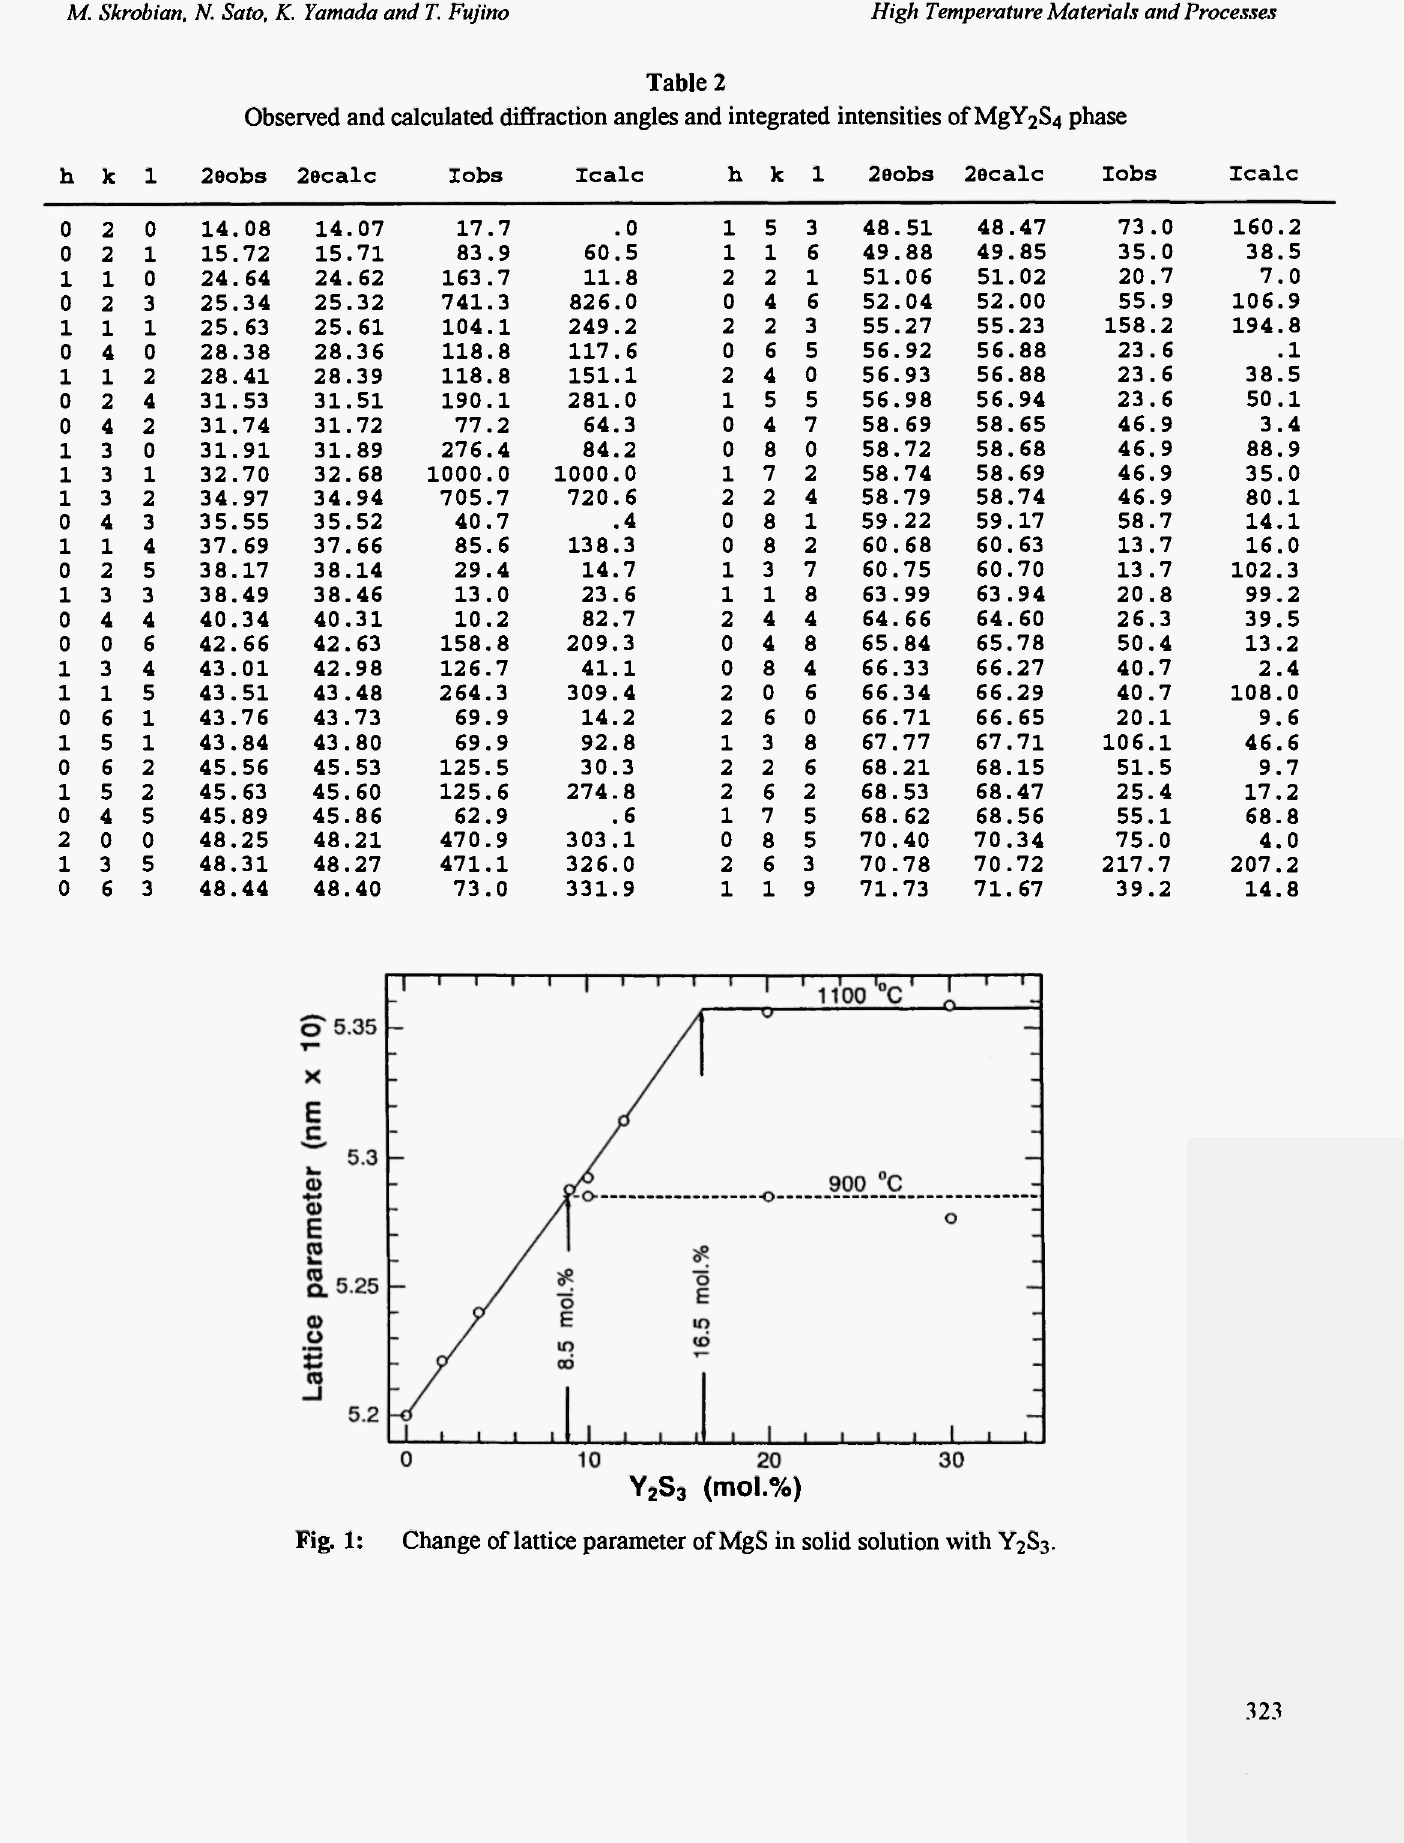
Observed and calculated diffraction angles and integrated intensities of MgY2S4 phase